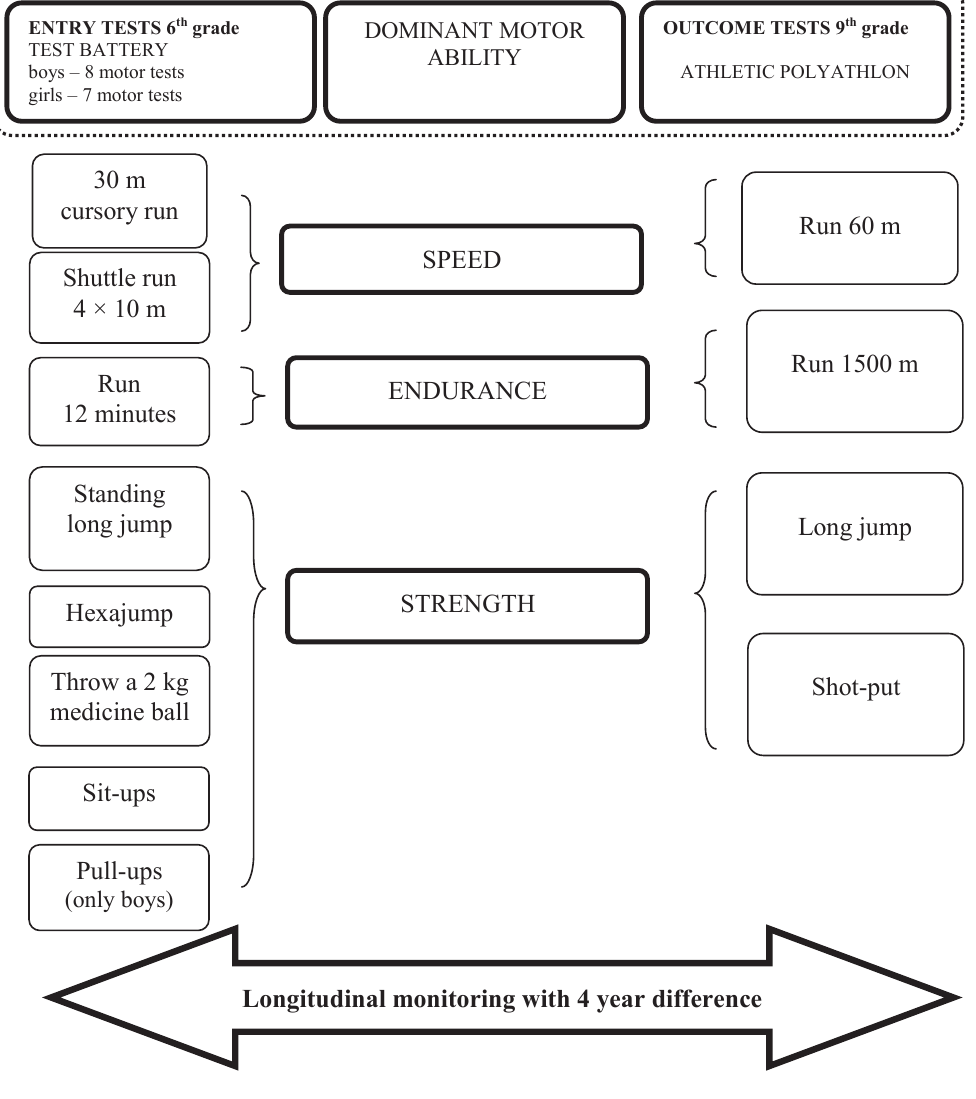
Figure 1. The scheme of research, entry and outgoing motor tests used in longitudinal